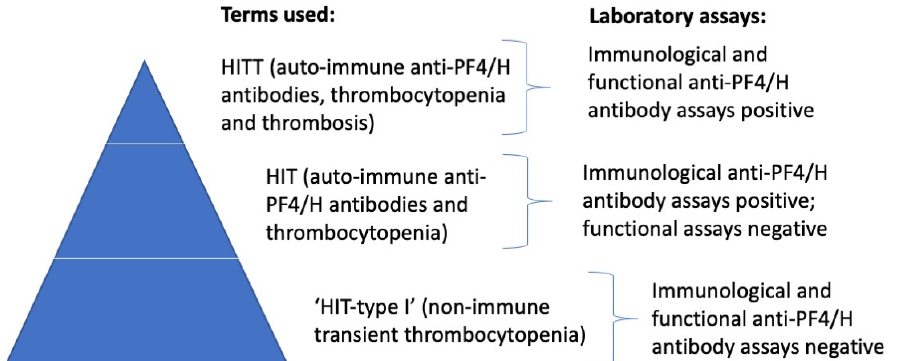
Figure 1. The HIT pyramid. Most patients with thrombocytopenia after initiation of heparin therapy will reflect a non-immune and transient platelet drop; these patients will be negative for anti-PF4 antibodies using immunological assays and functional platelet activation assays. However, some patients with thrombocytopenia after initiation of heparin therapy will reflect an immune-mediated platelet drop due to the production of anti-PF4 antibodies and the clearance of platelets (‘HIT’). These patients will be positive for anti-PF4 antibodies using immunological assays but negative by functional platelet activation assays. Only a small proportion of patients (at the ‘top’ of the pyramid) will have HITT, being HIT patients with resultant thrombosis, due to platelet activation, aggregation, and thrombotic vessel occlusion. These patients will be positive for anti-PF4 antibodies using immunological assays, as well as by functional platelet activation assays.